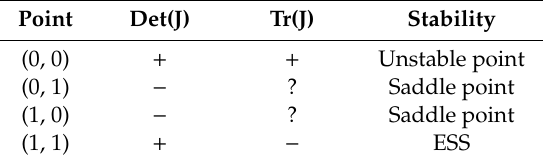
Table 8. Stability analysis of the points in case